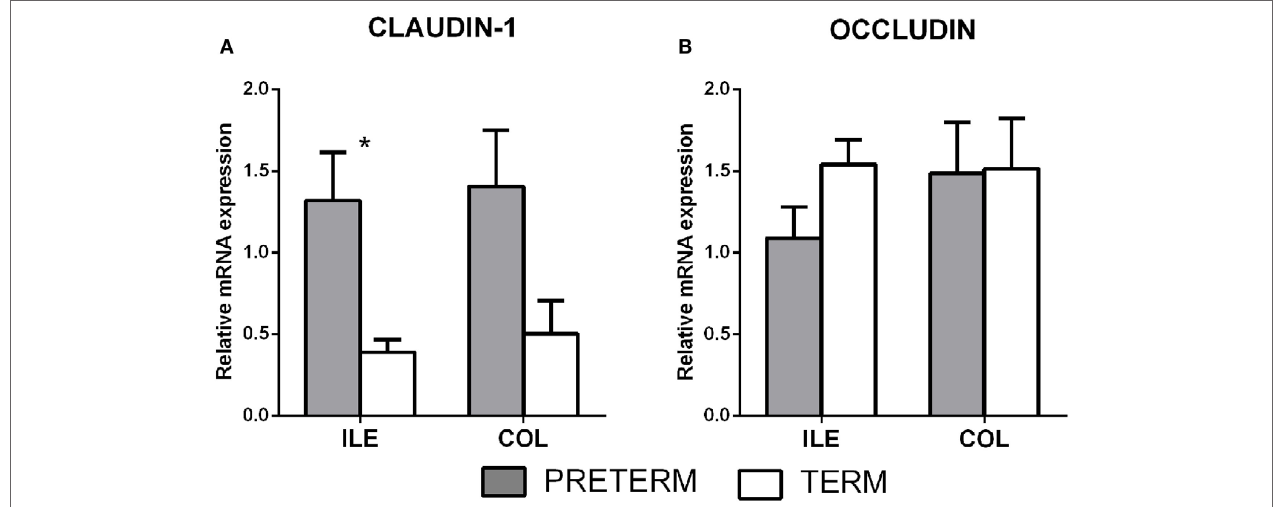
FigUre 2 | Transcription of claudin-1 and occludin in the intestine of the preterm and term germ-free piglets. The preterm piglets ( n = 10) are shown in the gray column, and the term piglets ( n = 6) by the white column (a,B) . The results are presented as the mean + SEM. The statistically significant differences in claudin-1 transcription in the ileum are denoted with an asterisk ( P <